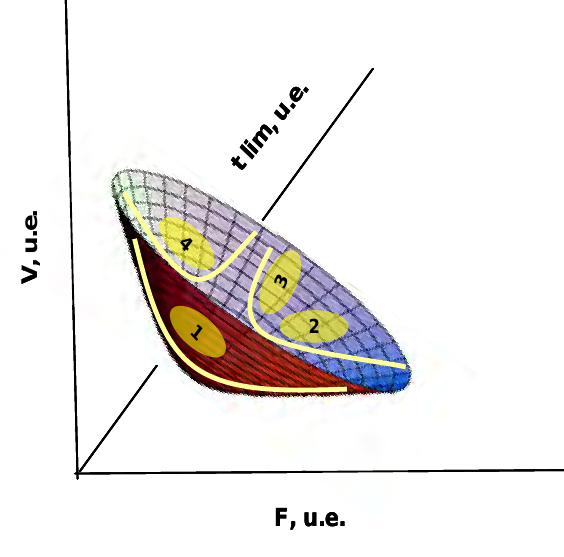
Fig.4. Diagram of interconnection of power, speed and maximal possible time of muscular work in the form of upper part of two-cavity hyperboloid; different sectors of hyperboloid correspond to manifestation of different physical